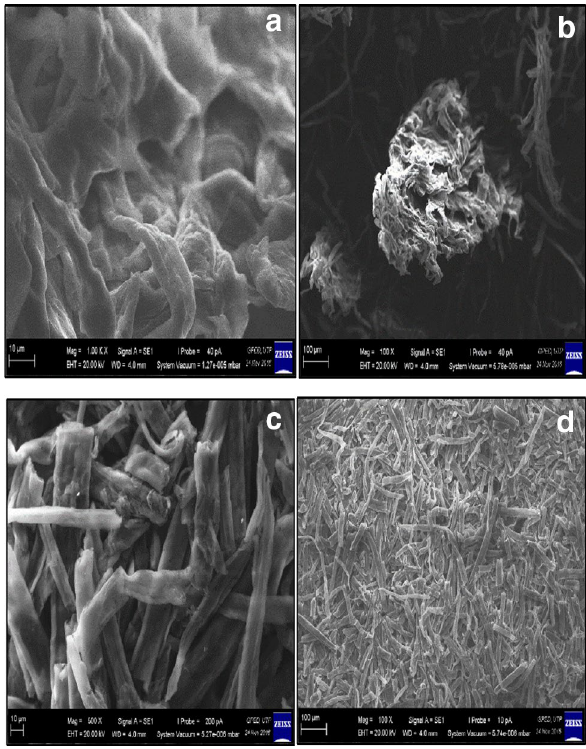
Fig. 1 a , b SEM images of nanocellulose, c , d SEM images for nano- cellulose-based surfactant